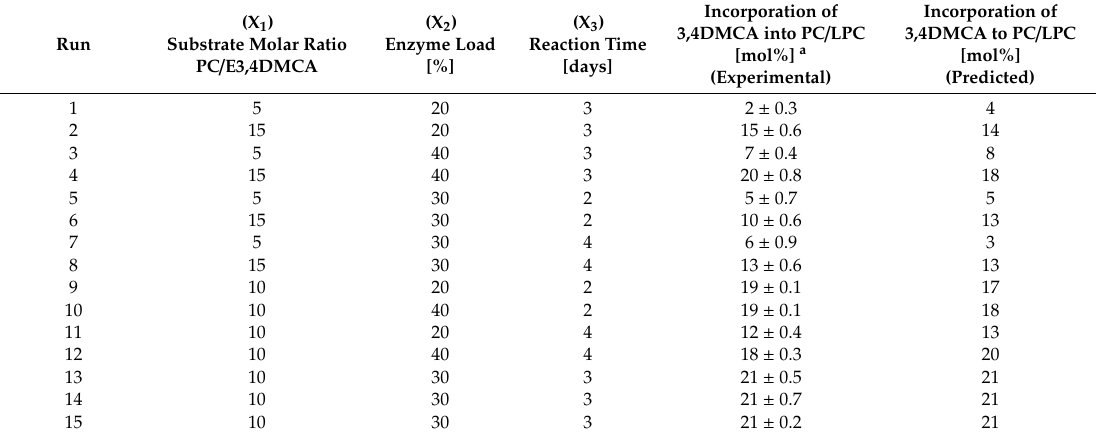
Table 1. Experimental and predicted value of incorporation of 3,4-dimethoxycinnamic acid (3,4DMCA) into phosphatidylcholine / lysophosphatidylcholine (PC / LPC) fraction in the Box-Behnken design.